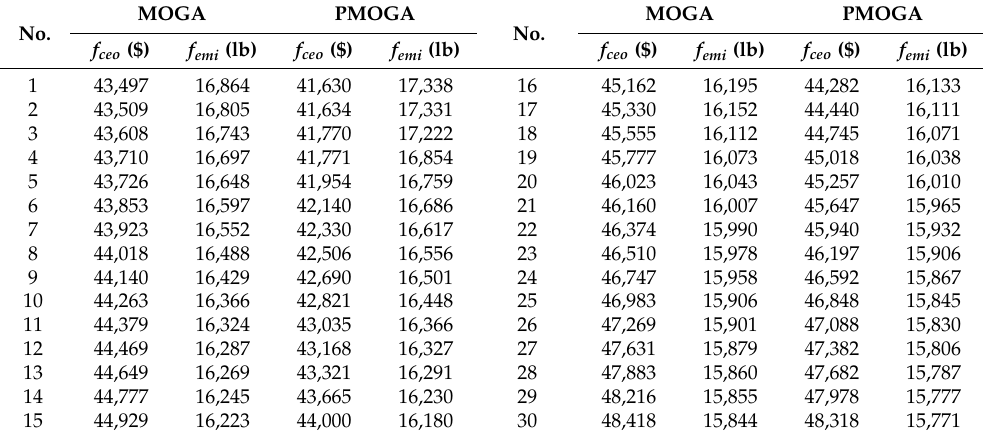
Table 3. The non-dominated schemes obtained by different methods for Case 2.